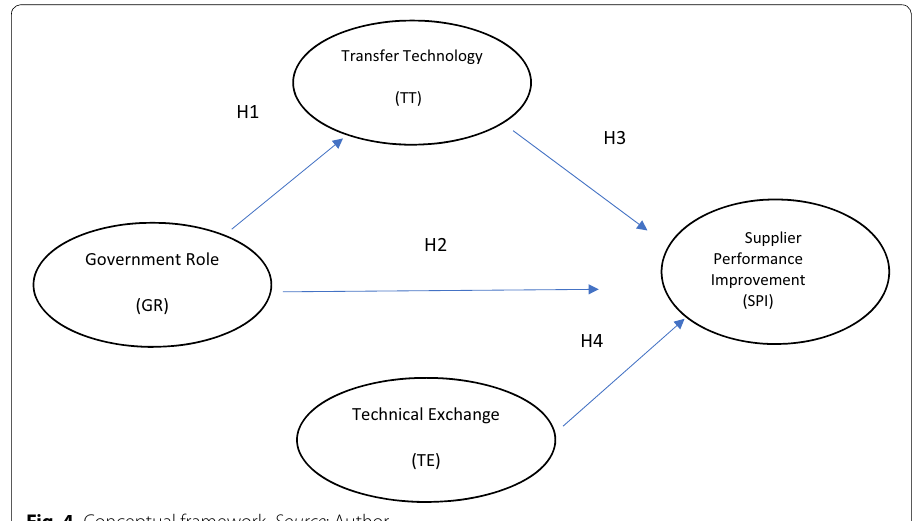
Fig. 4 Conceptual framework. Source :